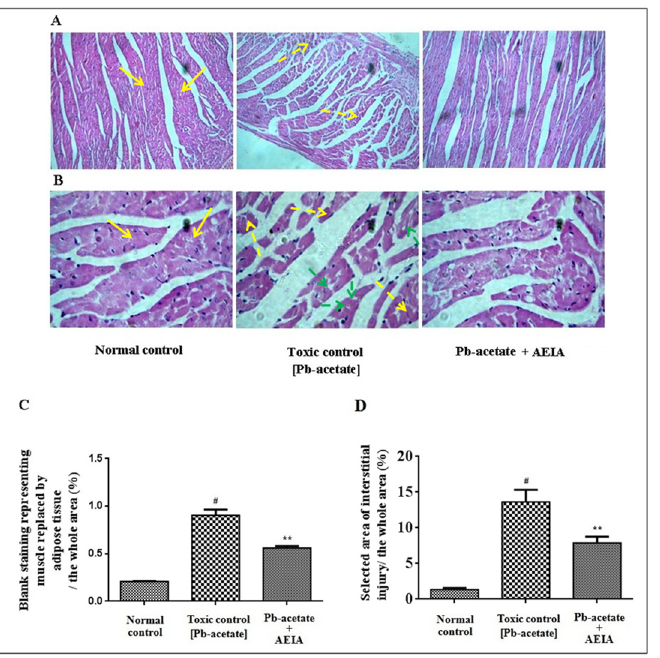
Fig 9. Histological sections 100 x (A) and 400 x (B) of hearts of experimental mice in the absence (Pb- acetate) and existence of AEIA (Pb-acetate + AEIA). Untreated mice were kept as normal control to compare the structural changes caused by Pb-acetate. Yellow arrows denote normal radiating pattern of cardiac muscle; yellow dotted arrows indicate excessive degradation in cardiac muscles and green dotted arrows represent replacement of muscle by adipose tissues during Pb-intoxication. C. The blank selected area represented the extent of cardiac muscle replaced by adipose tissue relative to the whole area of the photomicrograph (400 x, randomly selected areas). D. The selected area of interstitial injury relative to the whole area of the photomicrograph (400 x, randomly selected areas). Values are expressed as mean ± SE, (n = 60). # Values differ significantly from normal control (p < 0.01). ** Values significantly differed from Pb- acetate control (p <